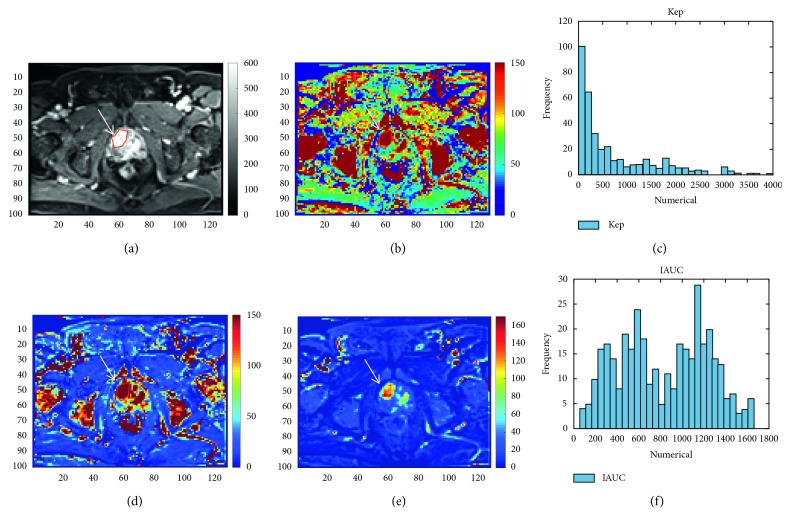
A DCE image and its derived parameter maps at the prostate region of a 76-year-old man who underwent simultaneous 11C-choline PET/MRI and had a prostate-specific antigen level of 76.6 ng/ml. A region of interest (ROI) was drawn in the cancer localized at the right lobe of the prostate gland (arrows) to obtain ROI histograms on DCE parameter maps. The Ktransmax, Ktranskur, Kepmax, Kepkur, iAUCmax, and iAUCkur values for prostate cancers in this patient were 3993.0/min, 3.34, 4000.0/min, 4.46, 1716.0, and 1.66, respectively. (a) DCE. (b) Ktrans. (c) Kep histogram. (d) Kep. (e) iAUC. (f) iAUC histogram.